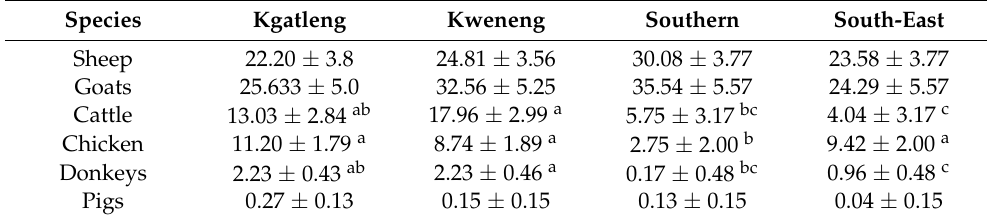
Table 2. Average number of livestock species per household in the four surveyed districts of Southern